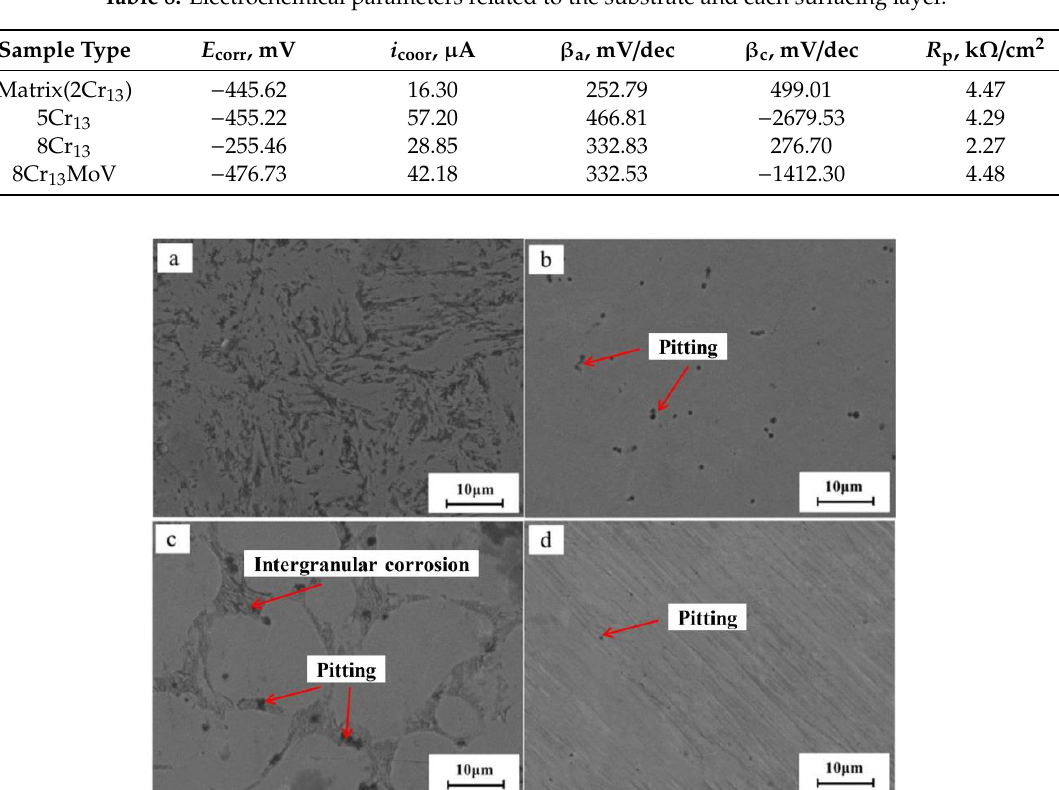
Figure 12. Electrochemical corrosion morphology. ( a ) matrix (2Cr13); ( b ) 5Cr13; ( c ) 8Cr13; ( d ) 8Cr13MoV.